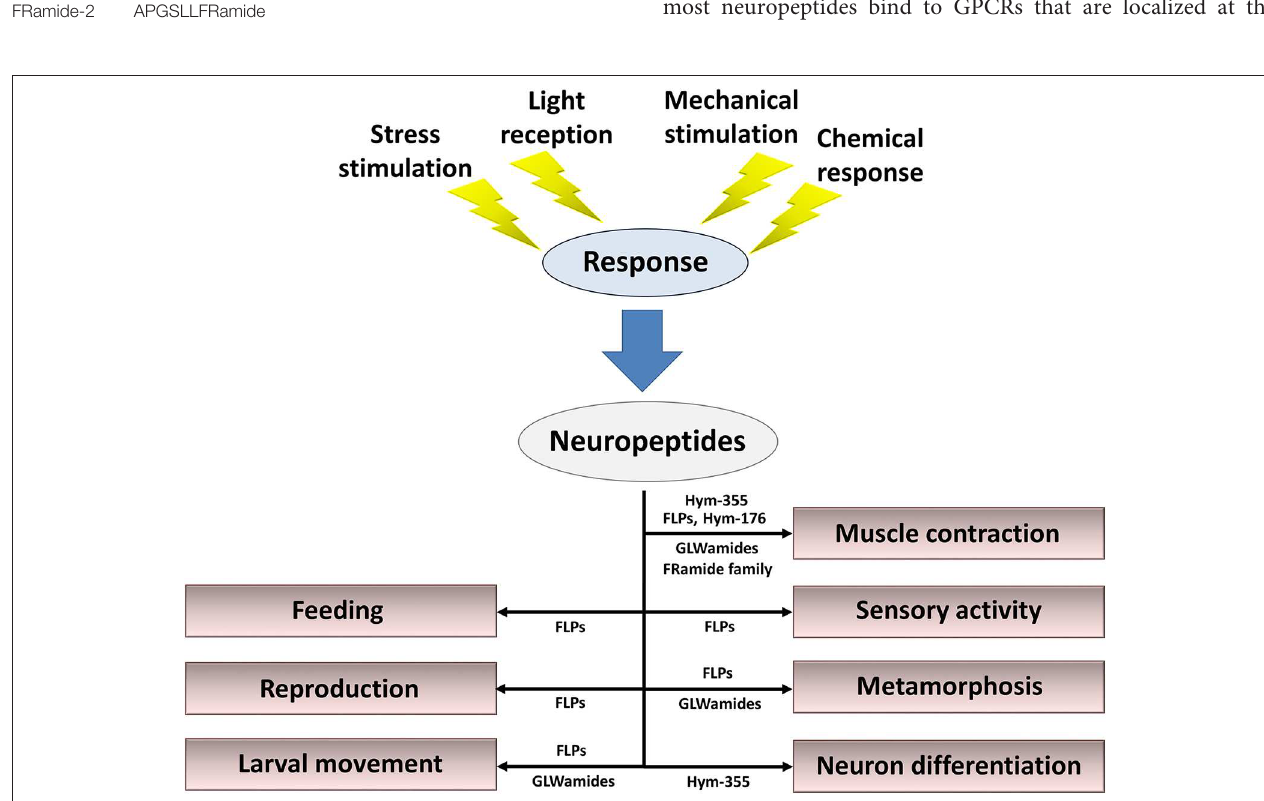
FIGURE 4 | Summary of roles for neuropeptides in the control of behavior, reproduction, metamorphosis, and tissue maintenance. Cnidarian peptide signaling molecules function together and/or separately to maintain the organism’s lifestyle in response to stress stimulation, light reception, mechanical stimulation, and chemical